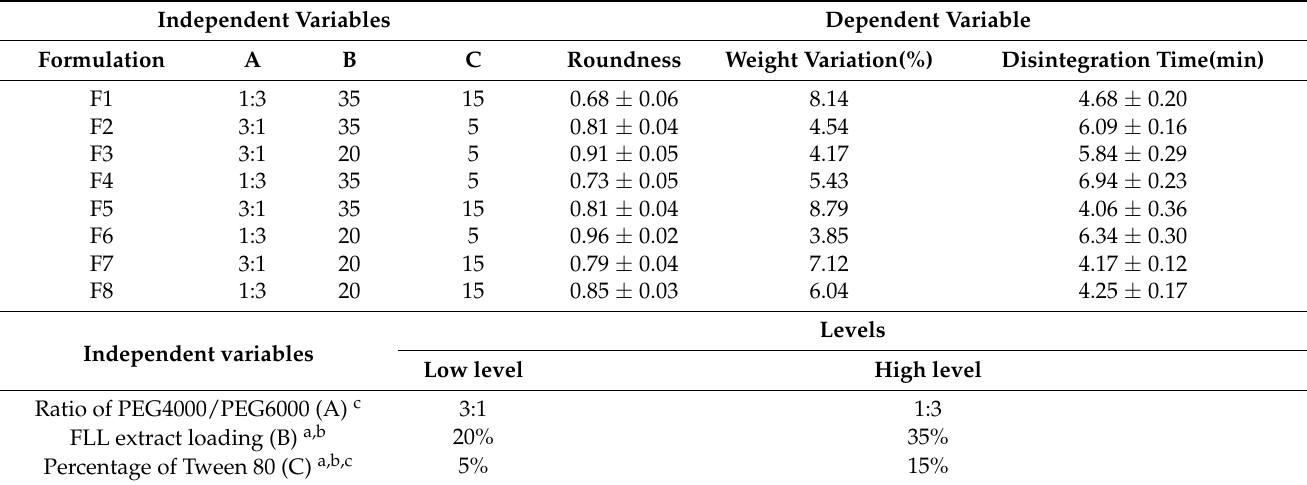
Table 1. The 2 3 full factorial design matrix and response results for dropping